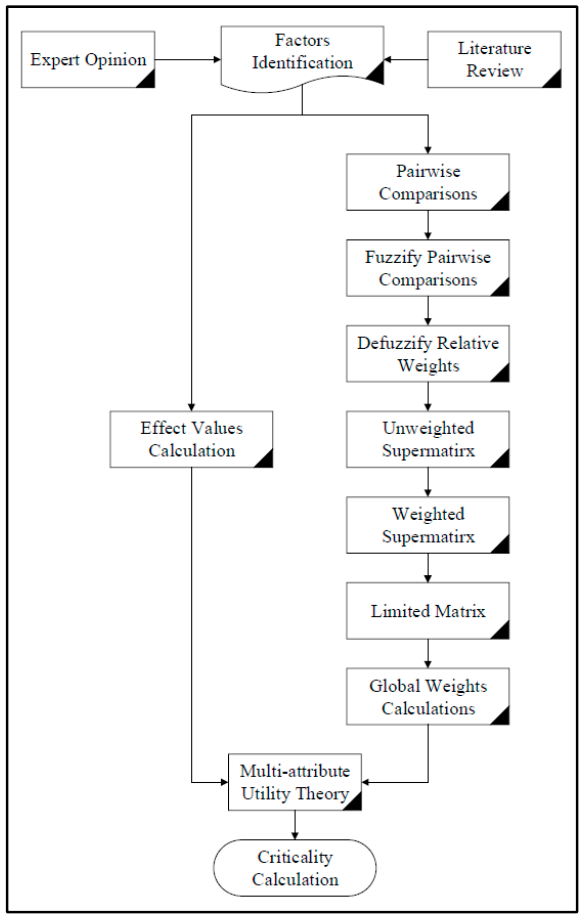
Water 2019 , 11 , x FOR PEER REVIEW Figure 4. Flow diagram of criticality assessment process. Figure 4. Flow diagram of criticality assessment process.